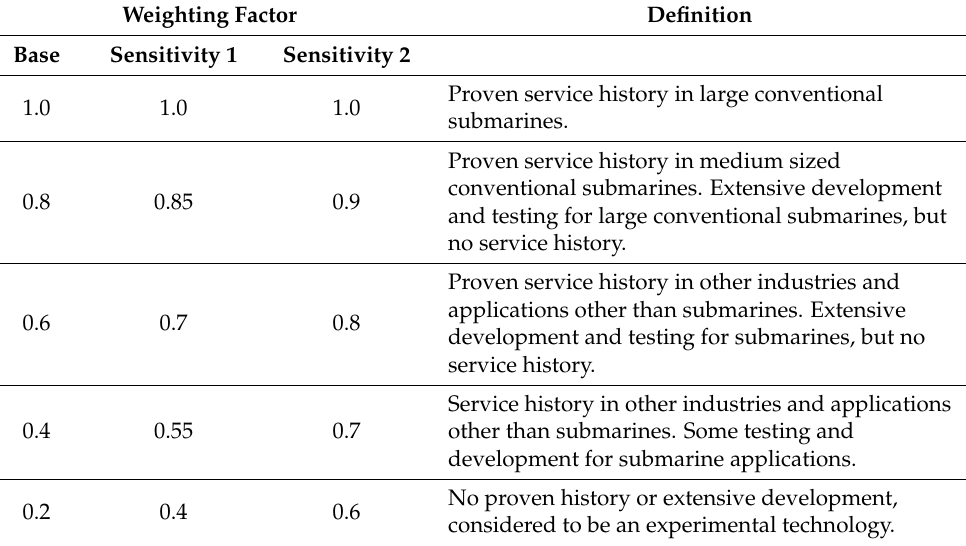
Table 9. Technology Maturity Risk Weighting